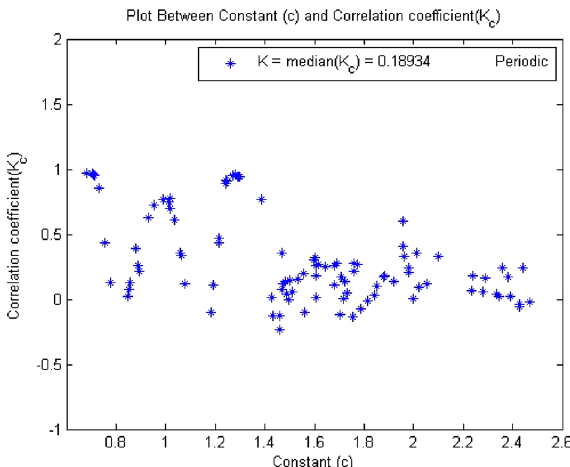
Figure 14. Plot of c vs K c and shows periodic behavior as K = 0.189.